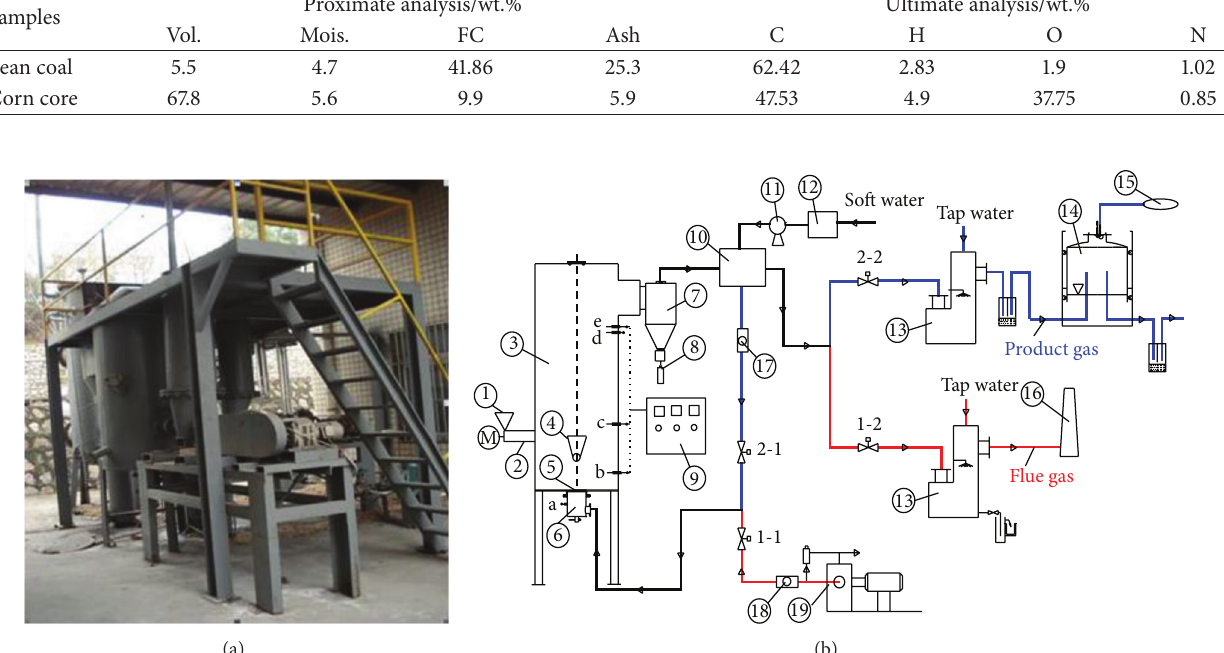
Figure 1: Cogasification of coal and biomass in an intermittent fluidized bed reactor. (a) Pilot plant, (b) schematic diagram: (1) biomass hopper; (2) screw feeder; (3) fluidized bed reactor; (4) coal feeder; (5) air distributor; (6) wind room; (7) high-temperature cyclone separator; (8) charcollector; (9) PIDtemperaturecontroller; (10) tube-typeheatexchanger; (11) softwaterpump; (12) softwatertank; (13) wetscrubber; (14) bell-type gas holder; (15) product gas collection bag; (16) chimney; (17) steam flow meter; (18) air flow meter; (19) roots blower, (b), (c) and (e): k-type thermocouple, (a) and (d): pressure taps; 1-1: air control valve (solenoid valve); 1-2: flue control valve (pneumatic valve); 2-1: steam control valve (solenoid valve); 2-2: gas control valve (pneumatic